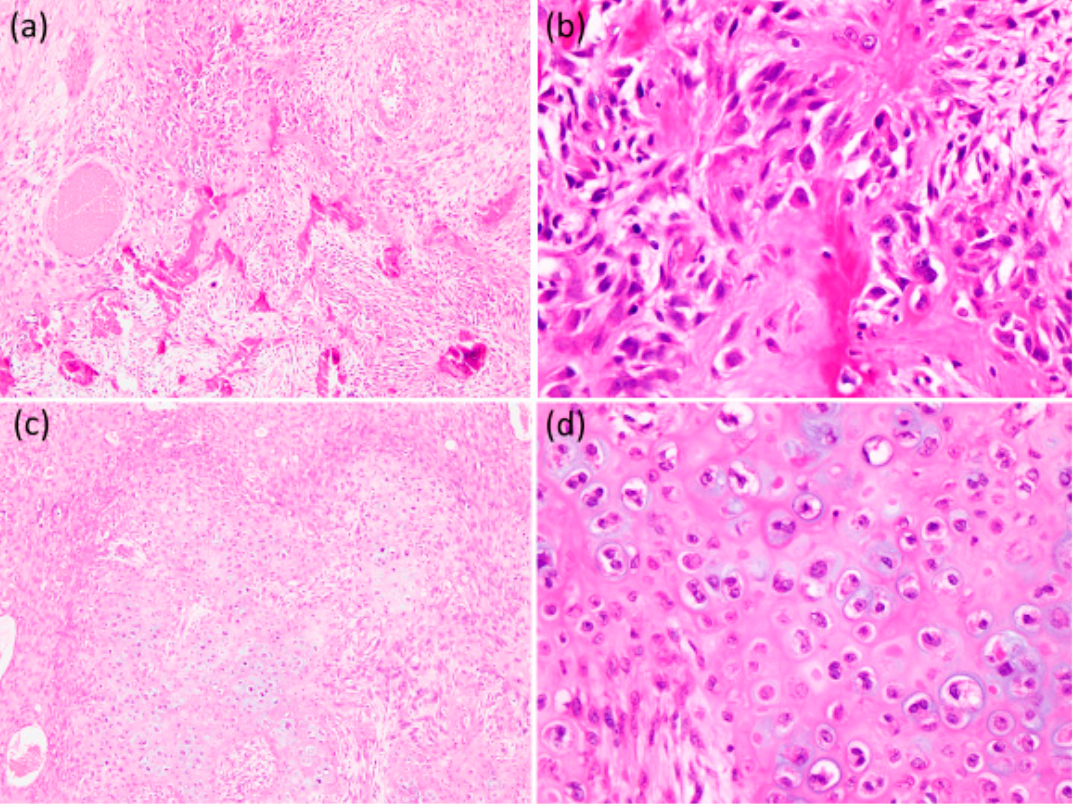
Figure 6. Histological findings of the tumor. ( a ) There were foci of osteoid and irregular trabeculae formation (100 × ). ( b ) It showed a proliferation of short-spindle and polygonal-shaped atypical cells with hyperchromatic nuclei (400 × ). ( c ) The foci of lobules of cartilage formation were found (100 × ). ( d ) Increased cellularity and atypical round-to-oval cells in lacunae were noted (400×).